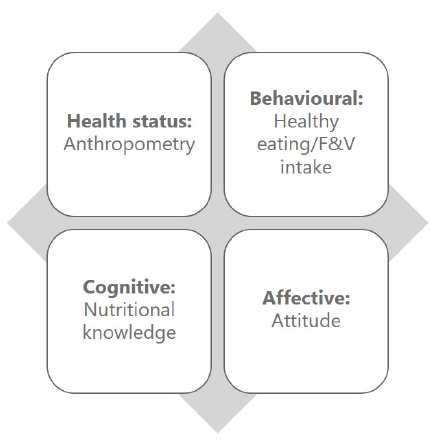
Figure 1. Outcome measures model. The figure illustrates the four types of outcome measures found in the interventions.